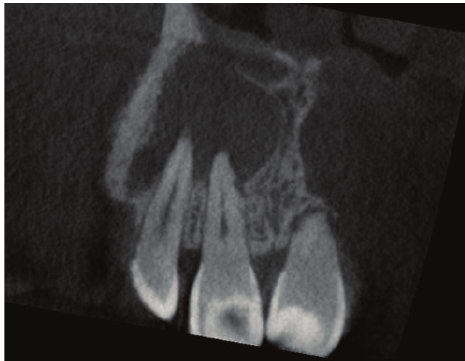
Figure 1: Preoperative photo showing presence of sinus tract with respect to 12 and 13.